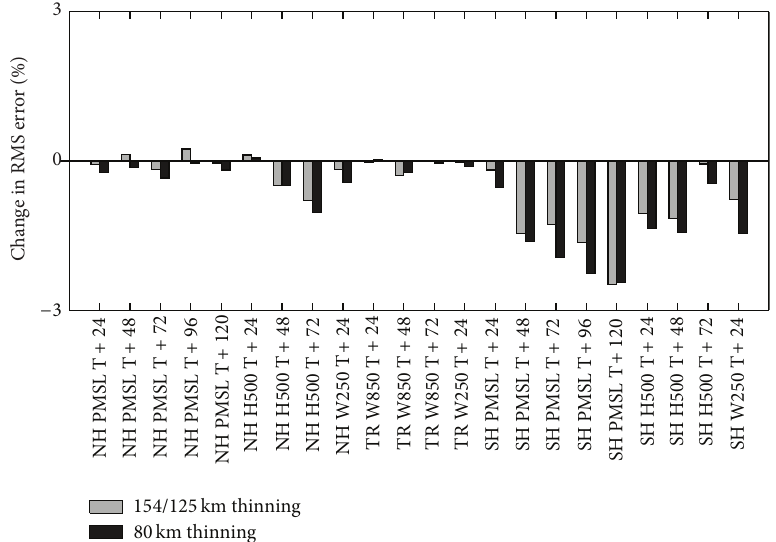
Figure9:Changesinrootmeansquare(RMS)errorsinmeansealevelpressure(PMSL),500hPageopotentialheight(H500)windsat850 hPa (W850) and 250 hPa (W250) for the northern hemisphere (NH), tropics (TR), and southern hemisphere (SH) at forecast ranges from T + 24 hours to T + 120 hours for experiments in which ATMS data is added with spatial thinning set to 125/154km and 80 km. Verification is relative to observations during the period 28 June–28 August 2012. Changes are relative to a control experiment which is similar in configuration to the Met Office operational configuration as at January